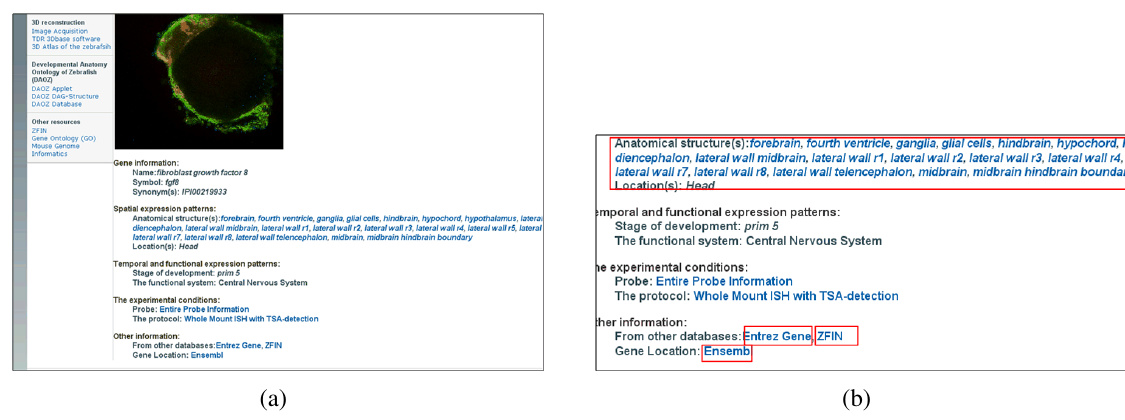
Figure 6: (a) The detailed view of a datasheet of a pattern of gene expression provides active links ((b) indicated with red boxes) for related information in ZFIN, Entrey Gene and